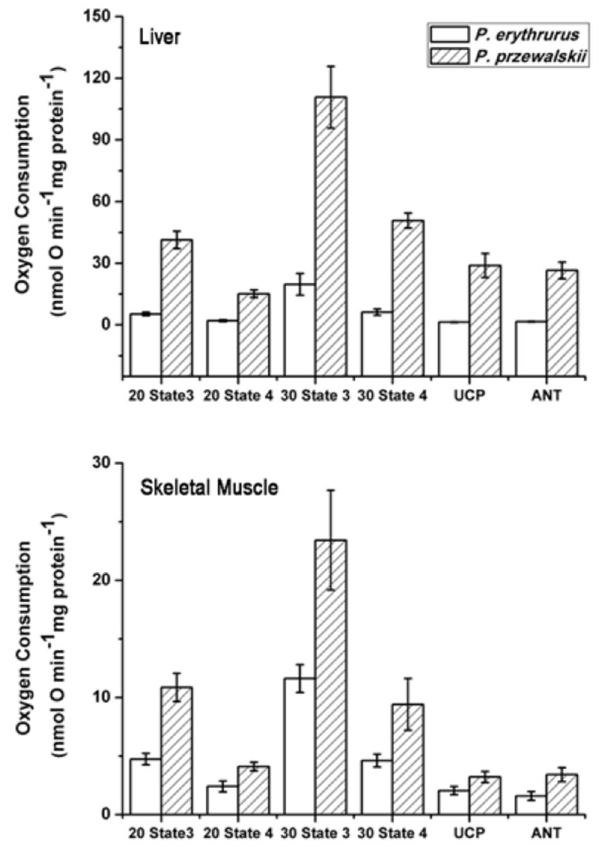
Figure 1. Mitochondrial respiratory rate and the uncoupling of liver and skeletal muscle in Phrynocephalus erythrurus and Phrynocephalus przewalskii ,